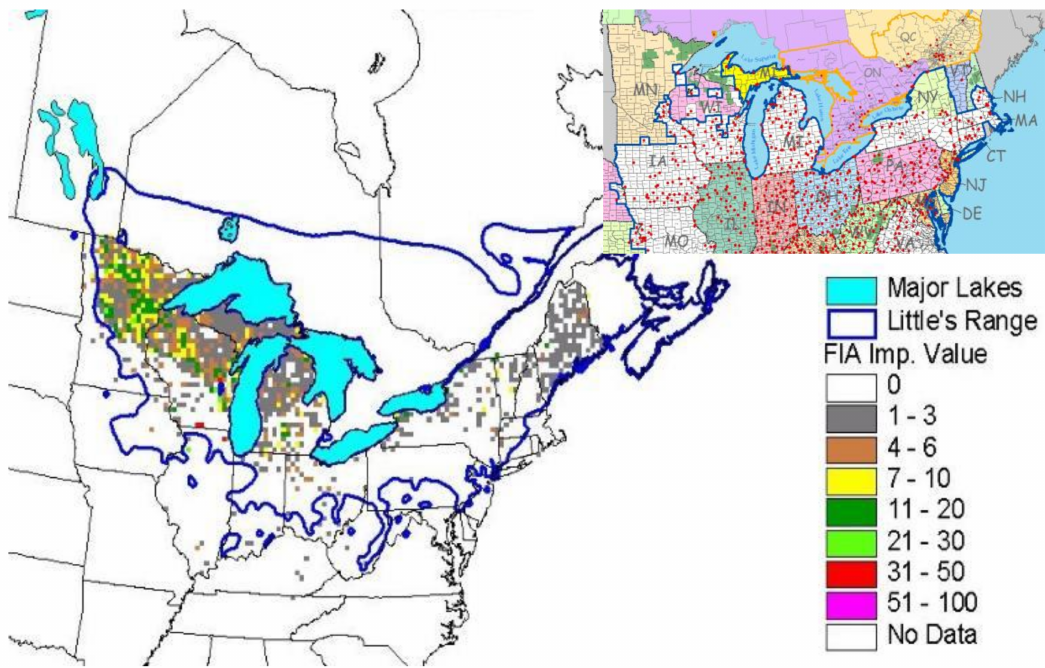
Figure 1. Geographic distribution of black ash in the United States from Forest Inventory and Analysis databases. Little’s range is the geographic range of black ash based on botanical lists, forest surveys, field notes, and herbarium specimens [11]. The Forest Inventory and Analysis importance value is a measure of the abundance of a species within a stand. An importance value of 50 indicates that the stand is 50% black ash and 50% other species. Inset is the geographic distribution of emerald ash borer detected in counties as of 1 March 2018